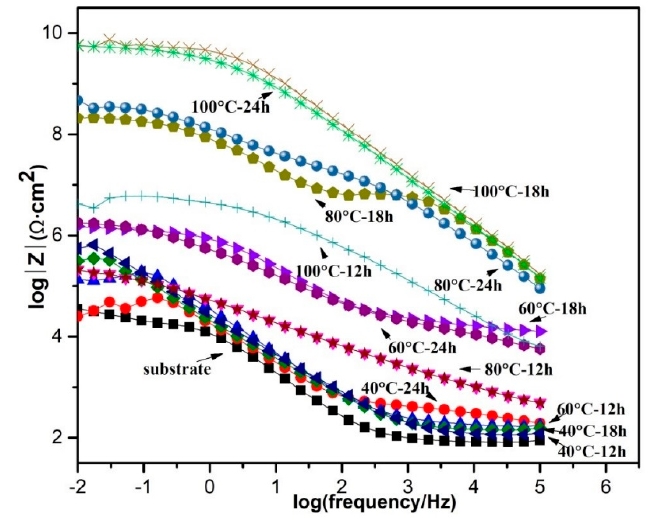
Figure 7. EIS spectra (Bode plots of log(| Z |) vs. log(frequency) ) of bare AA6082 alloy and AA6082 alloy coated with LDH film at various reaction temperatures and crystallization times in 0.1 M NaCl solution.